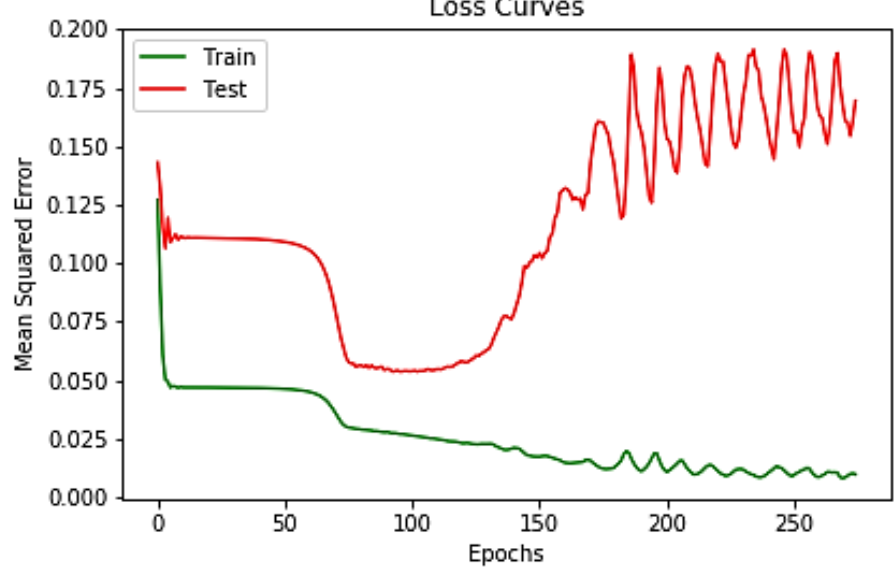
Figure 4. Mean squared error as a function of the number of epochs: a diverging model.